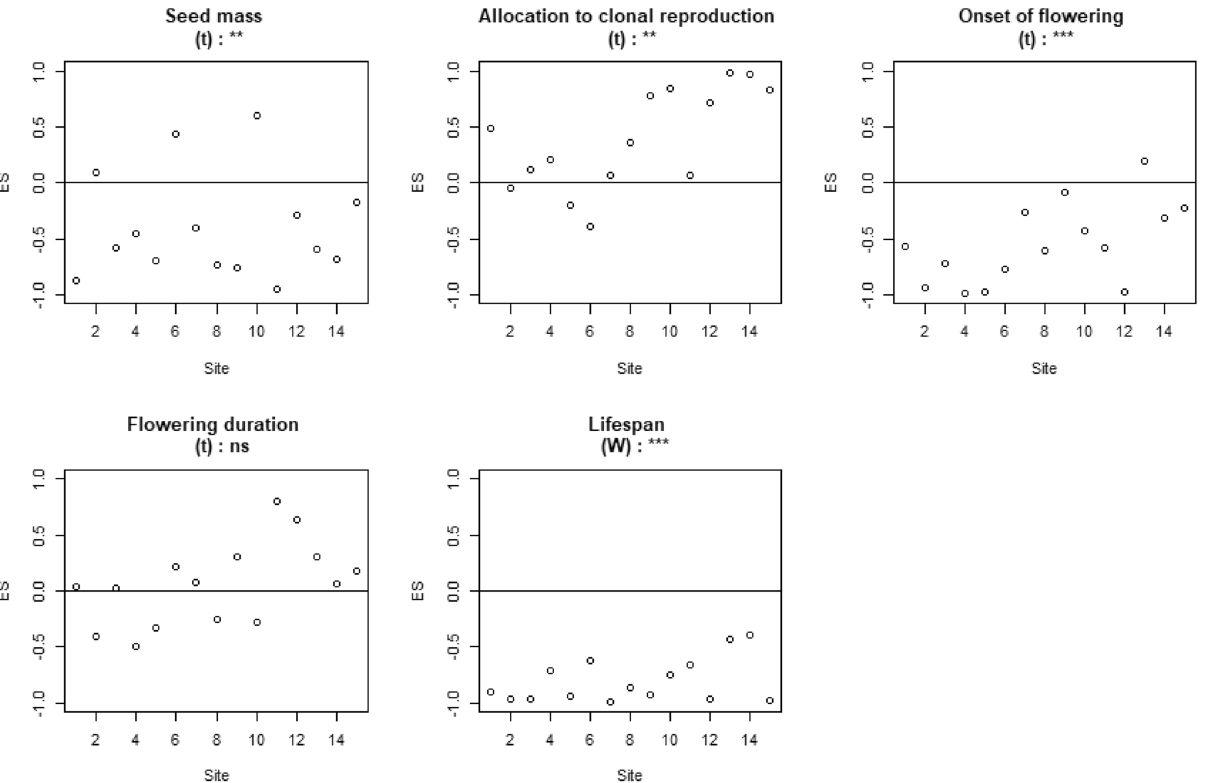
Figure 2. Effect size (ES) of hedgerow plant assemblages obtained using the “species occurrence rate model” (NM2) for each of the five traits: seed mass, allocation to clonal reproduction, onset of flowering, flowering duration and lifespan. Significance levels (***p < 0.001, **p < 0.01, *p < 0.05) and non-significance (ns) of the Wilcoxon tests (W) or Student’s t tests (t) are presented on top of each graph. Df = 17. This figure was created using R Software 81 (v. 4.02, https ://www.r-proje